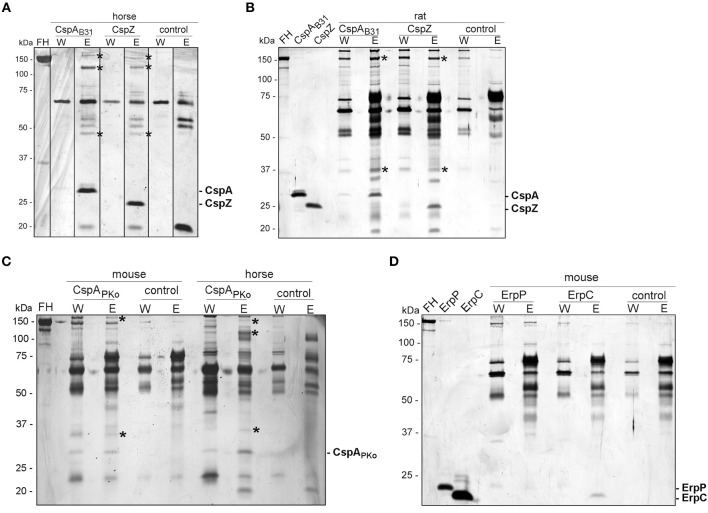
Identification of FH molecules bound to CRASP proteins. Purified, polyhistidine-tagged proteins (10 μg each) coupled onto magnetic beads were incubated with selected animal sera. Immobilized CspAB31 and CspZ were incubated with horse (A) or rat (B) serum, CspAPKo with mouse or horse serum (C) and ErpP and ErpC with mouse serum (D). Uncoated beads were also incubated under the same conditions and used as a control to identify non-specific binding of serum proteins. After extensive washing, bound proteins were eluted with 100 mM glycine and the eluate fractions were separated by glycine-SDS-PAGE, following silver staining. Protein bands indicated were cored from stained gels and proteins were identified by mass spectrometry. The mobility of the molecular mass standard is indicated on the left of each panel and recombinant proteins eluted were indicated on the right. The asterisks in panel A, B, and C indicated the protein bands analyzed by mass spectrometry.